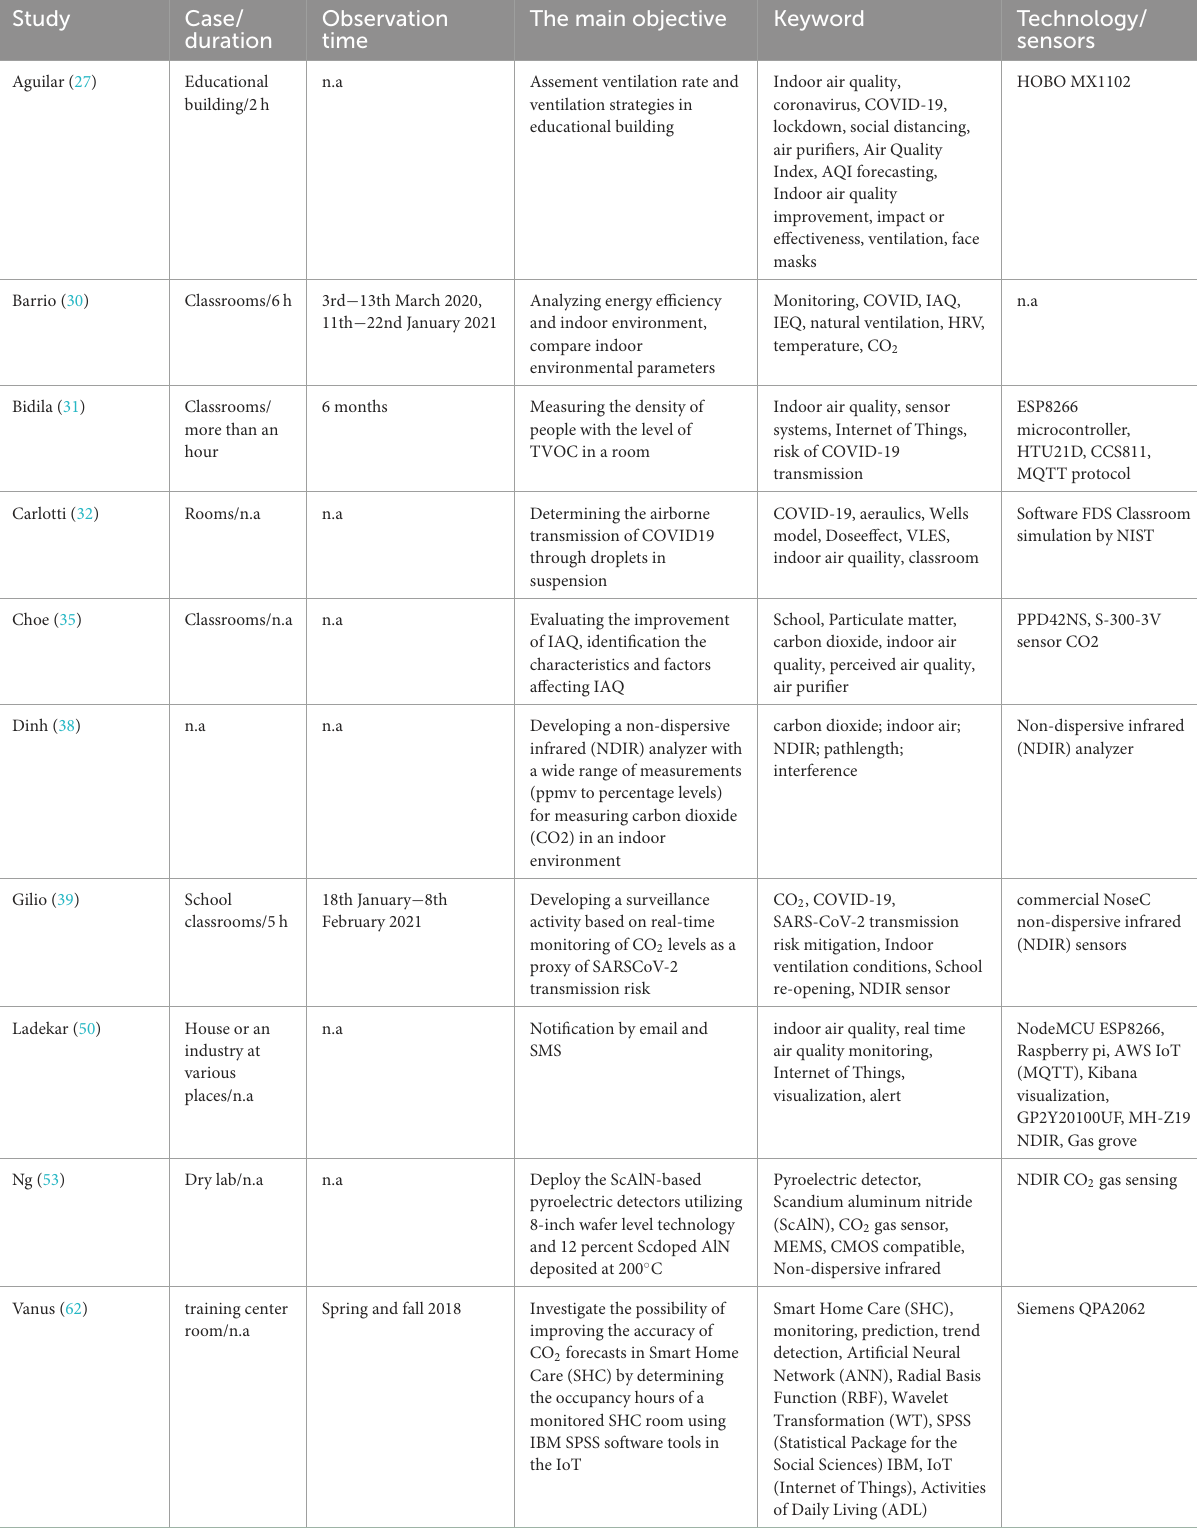
TABLE 5 Indoor air monitoring